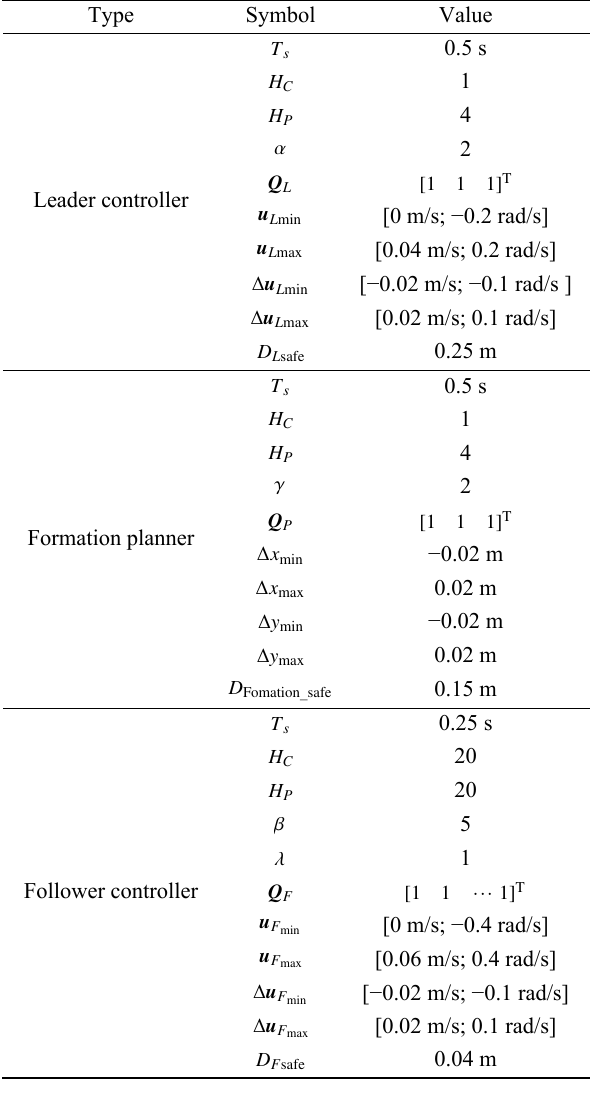
Table 1 Parameters of